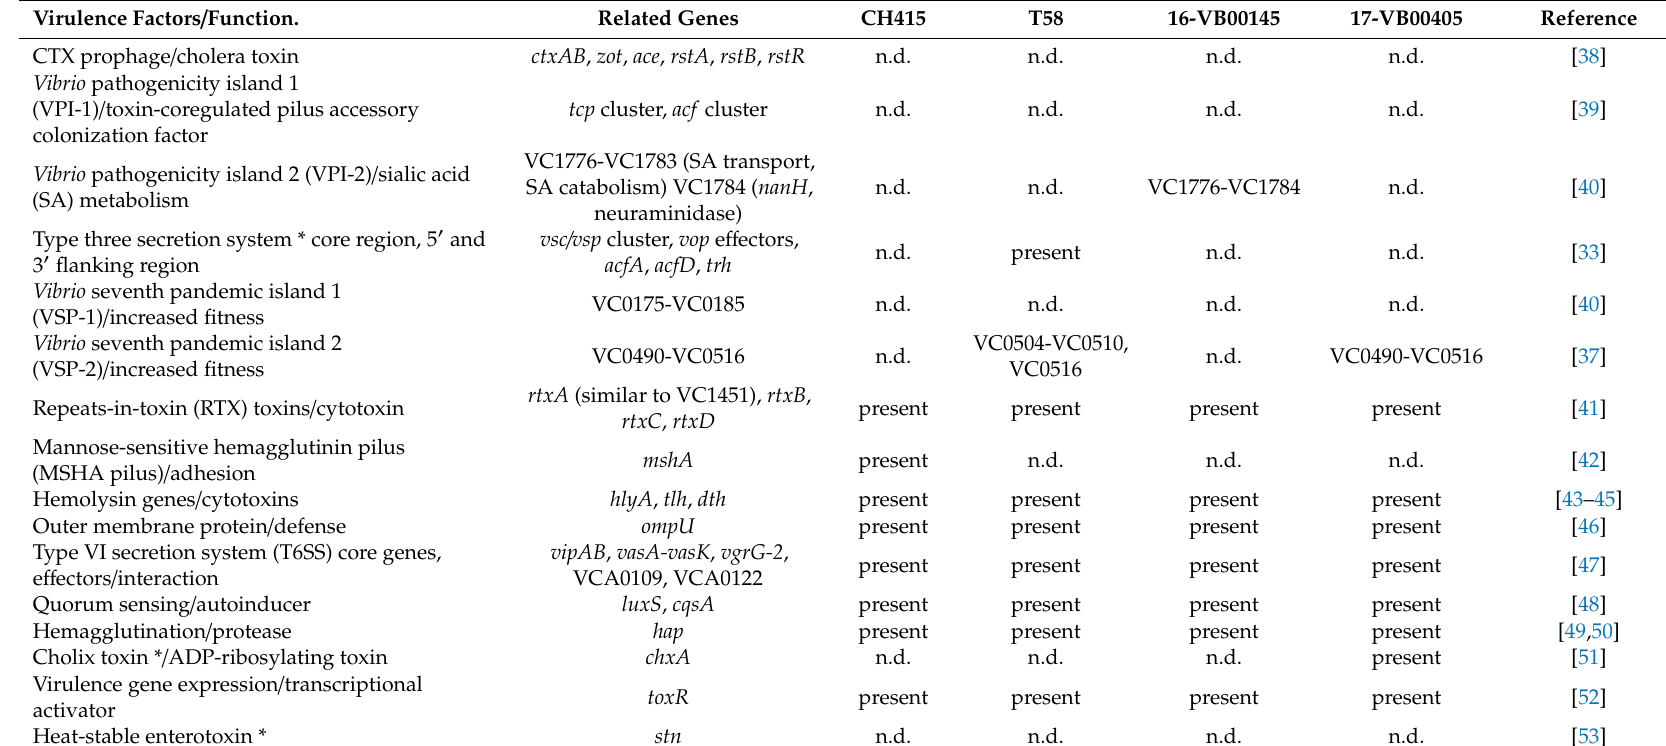
Table 4. Virulence factors found in duck